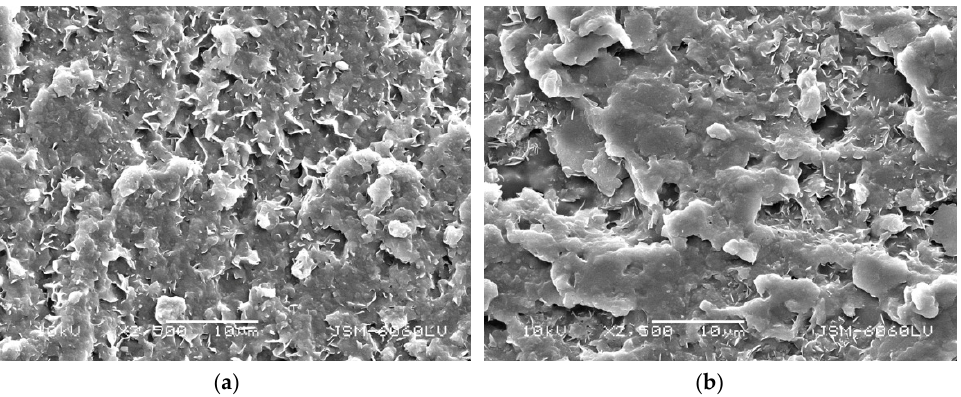
Figure 17. SEM images of EPDM plate samples after swelling in Polywash: ( a ) 10 × UV treatment, ( b ) 30 × UV treatment.